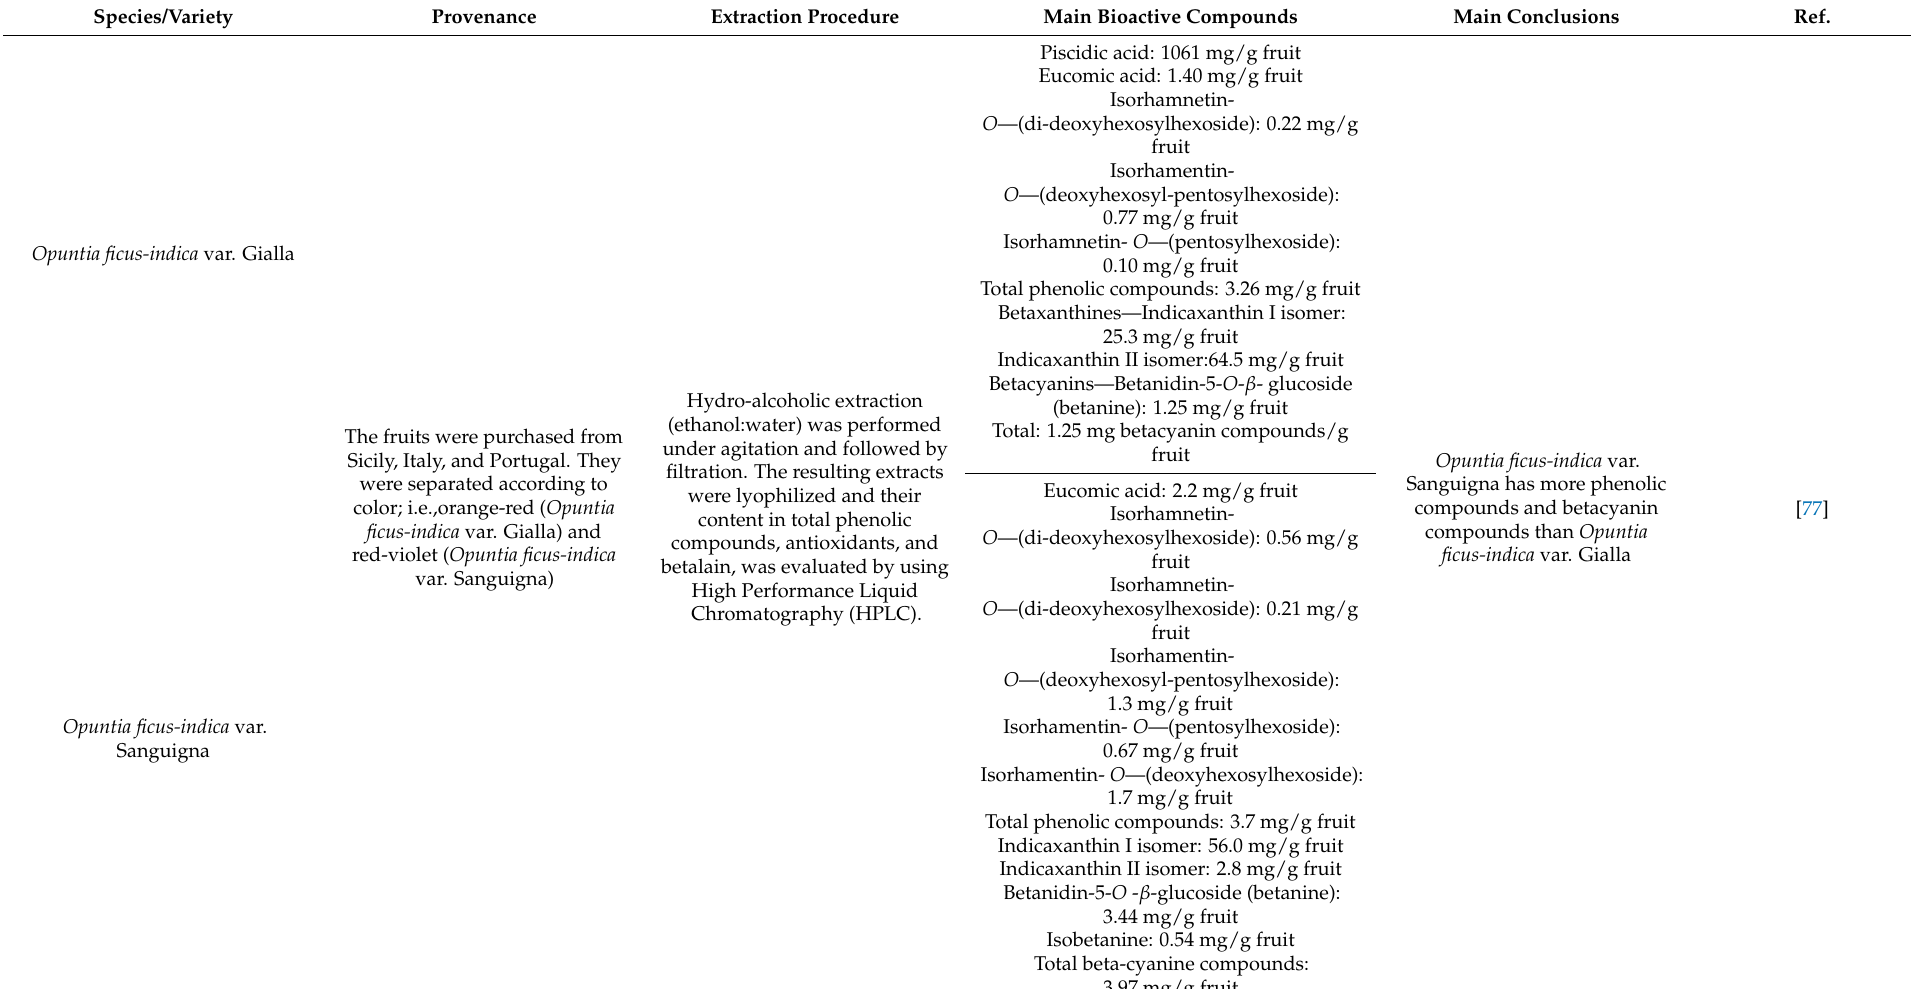
Table 3. Bioactive composition and extraction procedures of prickly pears and seed